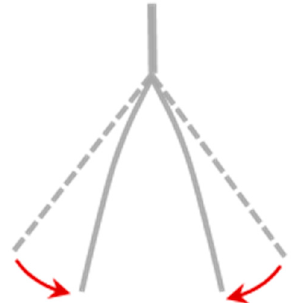
Figure 7. Sketch of the geometrical closure of the generic mesh when a load is applied in its plane; the closure is given both by a reduction of the vertices openings and the bending of the wires.